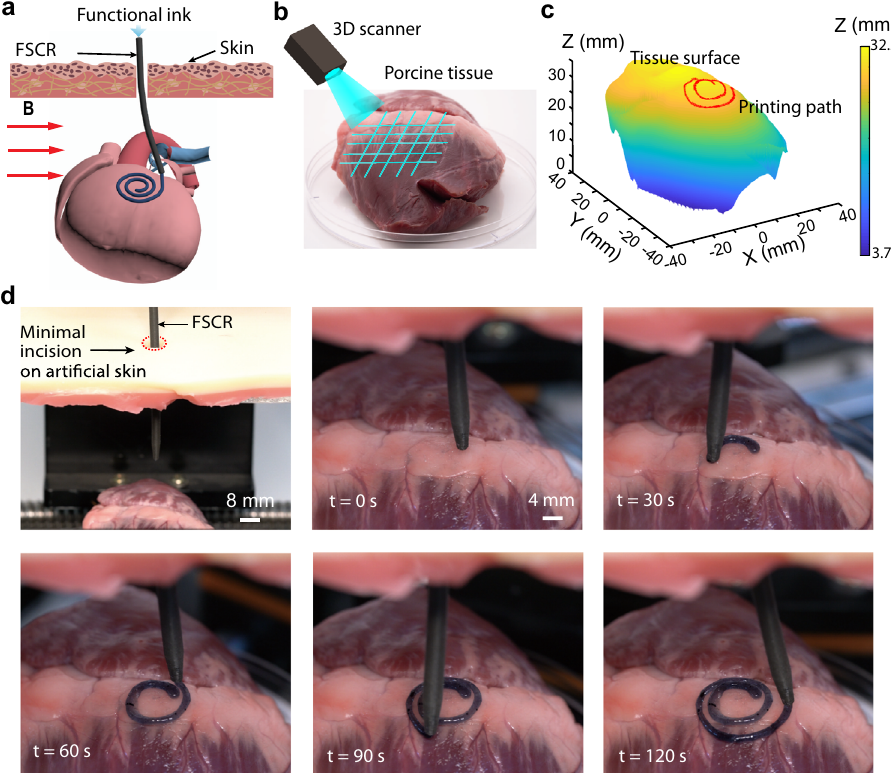
Fig. 5 In vitro minimally invasive bioprinting of conducting hydrogel on the porcine tissue surface. a Schematic illustration of the printing process on porcine tissue. b 3D scan and reconstruction of the curved surface of porcine tissue. c Design of the 3D spiral printing path on the reconstructed surface. The color represents the height magnitude. d Photographs of the minimally invasive bioprinting process of a conducting hydrogel on porcine tissue at various